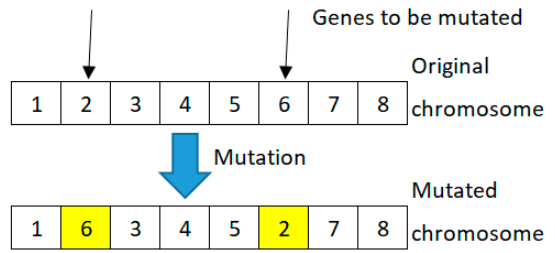
Figure 4. Gene mutation of chromosomes with length l = 8.